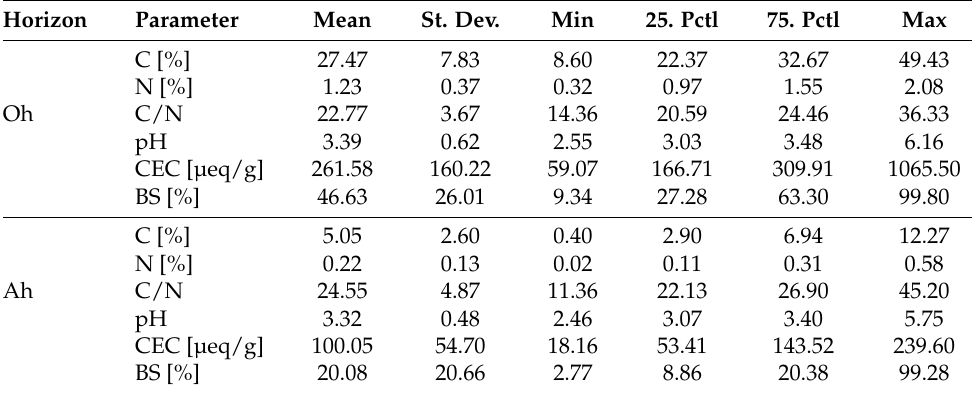
Table 3. Summary statistics of investigated soil properties for Oh (n = 172) and Ah (n = 178) horizon, Pctl =